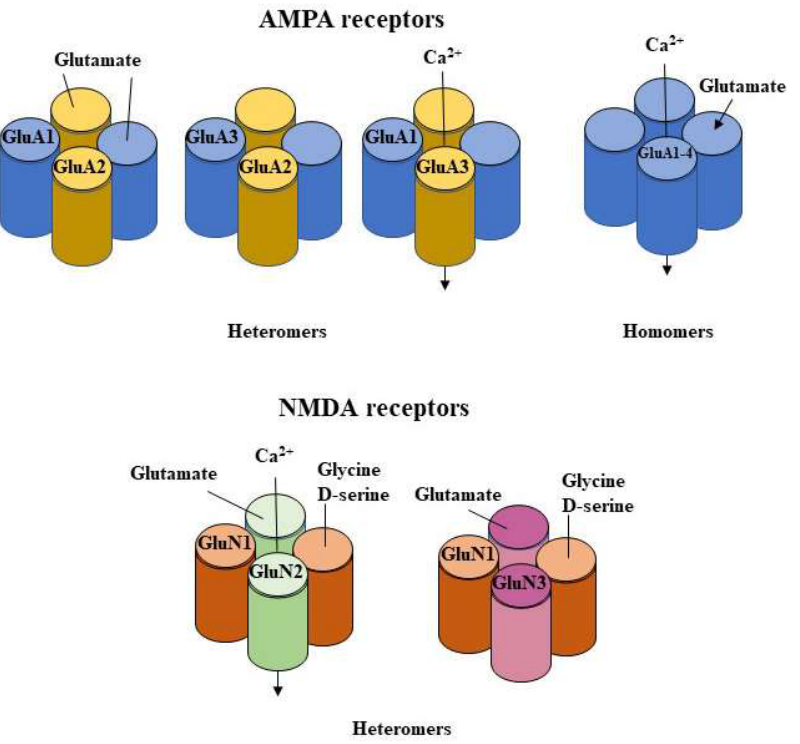
Figure 1. The diagram illustrates the structural diversity of AMPA and NMDA receptor subunits. Multiple subunits have been characterized in these receptor classes that bind either glutamate or glycine/D-serine. Subunits of AMPA receptors can form functional homomers and heteromers, but GluA2-containing heteromers are the most common in the brain [86]. AMPA receptors are classified as GluA2-containing (Ca 2+ -impermeable and insensitive to polyamines) and GluA2-lacking (Ca 2+ - permeable and blocked by polyamines). NMDA receptors exist as heteromeric receptors with two GluN1 subunits and two GluN2 subunits (GluN1/2) or two GluN3 subunits (GluN1/3). NMDA receptor activation requires the simultaneous binding of glycine (or D-serine) and glutamate to relieve the voltage-dependent Mg 2+ block and allow the flow of inward Ca 2+ [86].